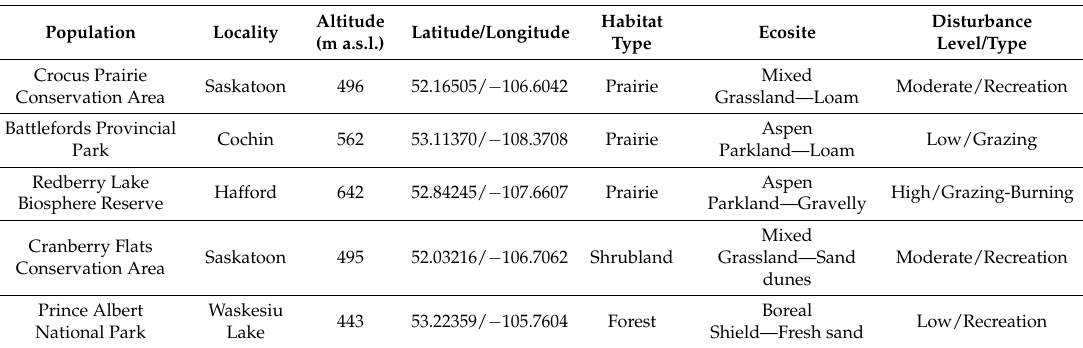
Table 5. Sampling locations of Anemone patens in Saskatchewan. Ecosites are identified based on Thorpe’s classification